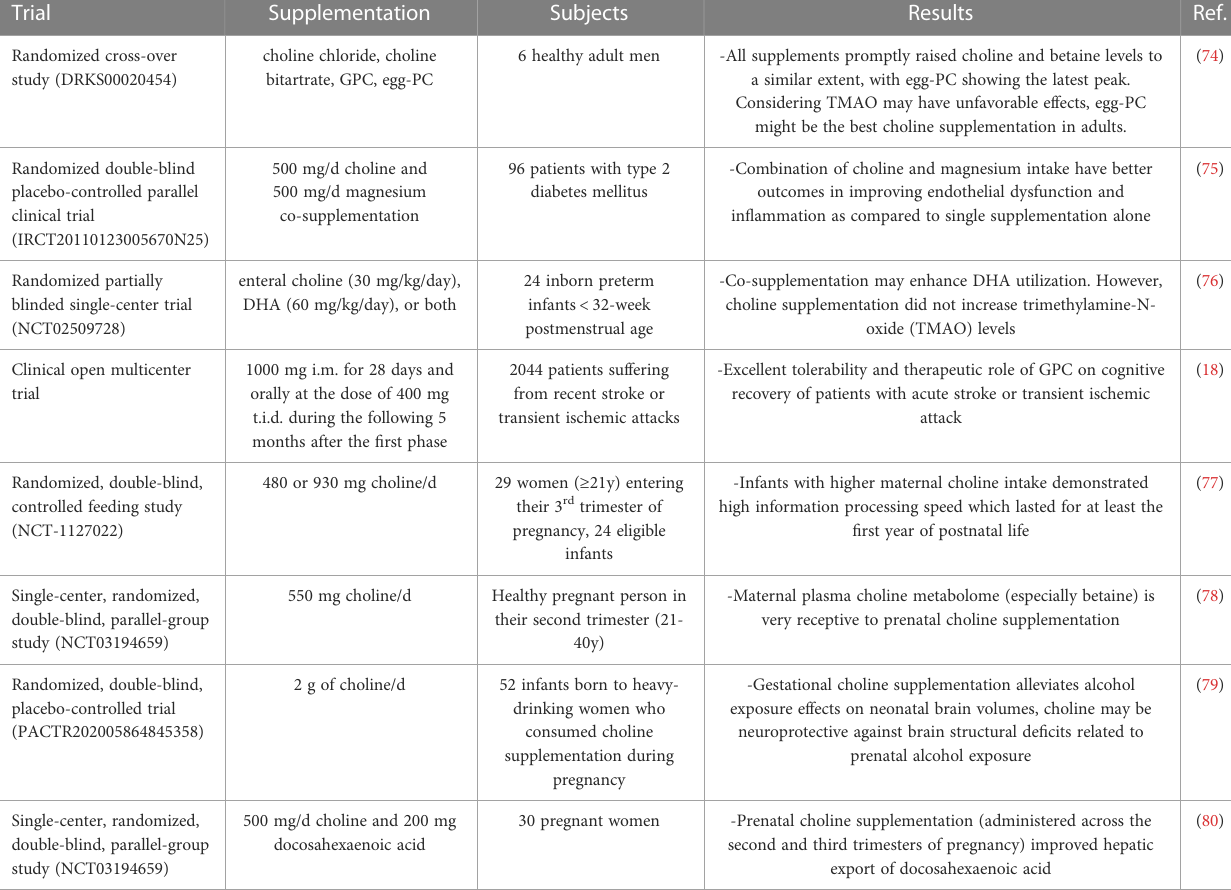
TABLE 3 Main clinical studies investigating choline supplementation. Trial Supplementation Subjects Results Ref.